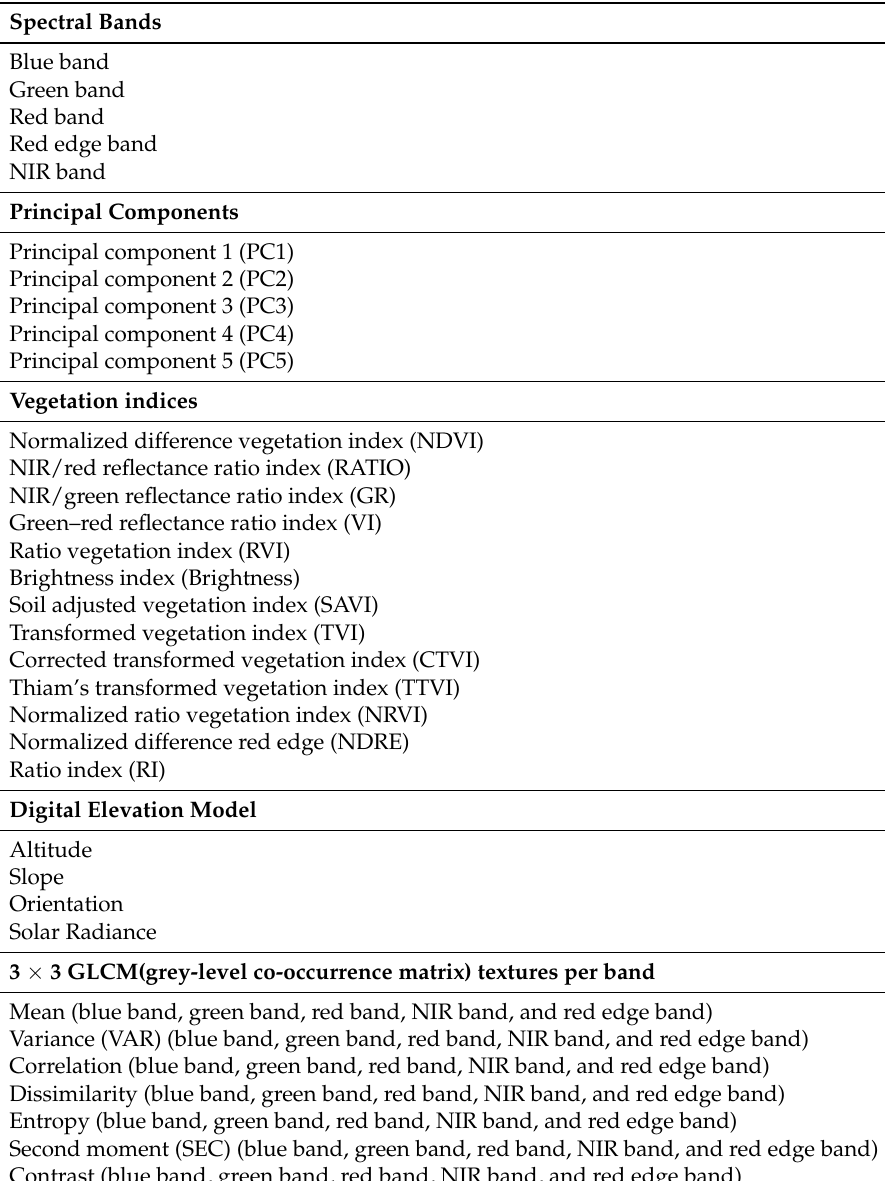
Table A2. Independent variables generated from the RapidEye